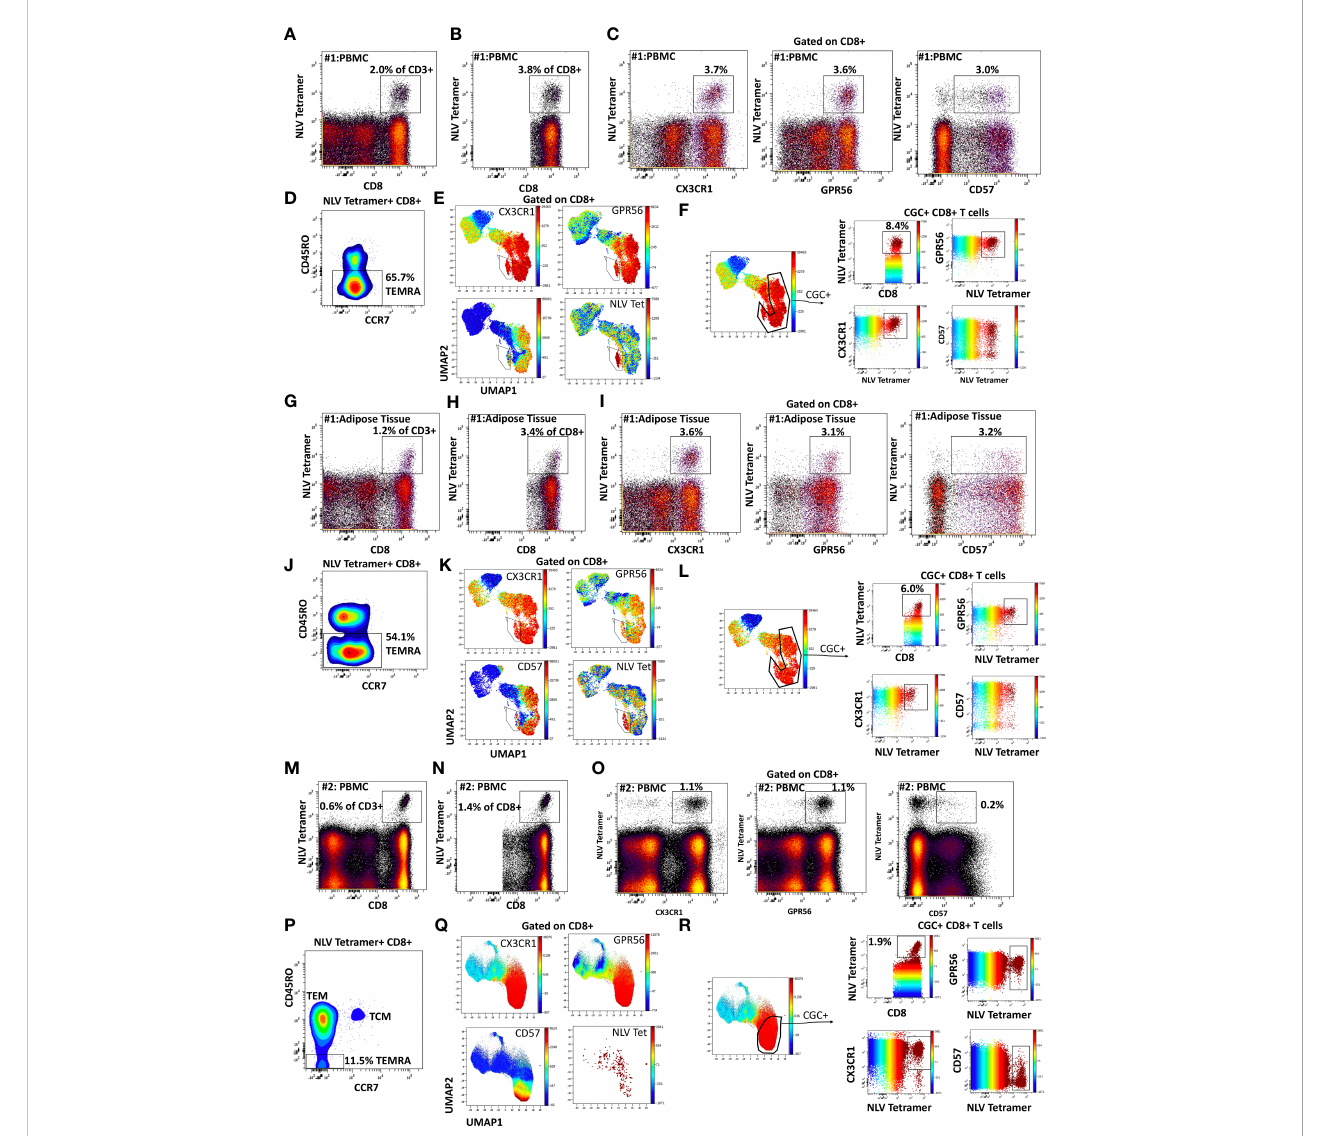
FIGURE 2 CMV-speci fi c CD8 + T cells are predominantly CGC + . Phenotypic expression of CX3CR1, GPR56, and CD57 by NLV-speci fi c CD8 + T cells in two participants. Peripheral blood NLV-speci fi c CD8 + T cells as a proportion of CD3 + T cells (A) and total CD8 + T cells (B) . Two-dimensional plots show the co-expression of CX3CR1, GPR56, and CD57 by NLV-speci fi c CD8 T cells (C) . Memory cell phenotypes were classi fi ed as TEM (CD45RO + CCR7 - ) and TEMRA (CD45RO - CCR7 - ) (D) . UMAP of CD8 + T cells showing the CD8 + T cells with NLV tetramers among the CGC cells (E, F) . The proportion of NLV- tetramer + CD8 + T cells in matched SVF fraction (G, H) . Co-expression of CGC markers (I) and memory T cell subsets (J) within UMAPs as the proportion of total CGC + CD8 + T cells (K, L) . A representative sample from the blood of a second participant sample is shown (M-R)